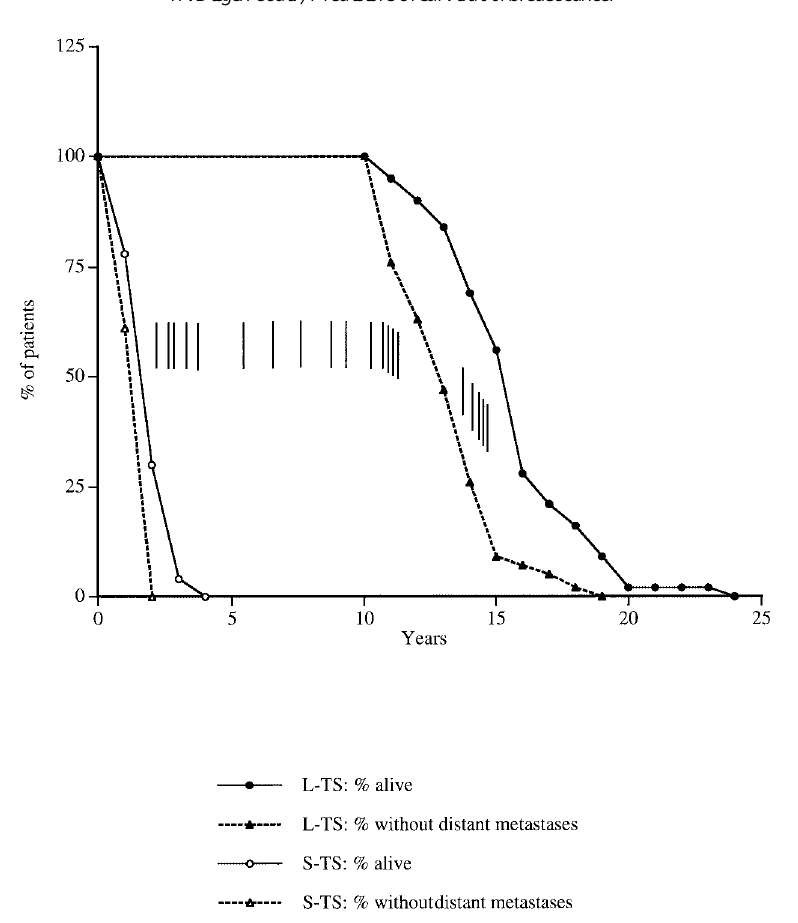
Fig. 1. Percent of patients without clinically detected distant metastases and patient survival time in years after primary diagnosis (L-TS = long-term survivors, S-TS = short-term survivors). The vertical bars indicate the time of detection of the first loco-regional recurrence or local lymph node metastasis after the primary diagnosis in the group of